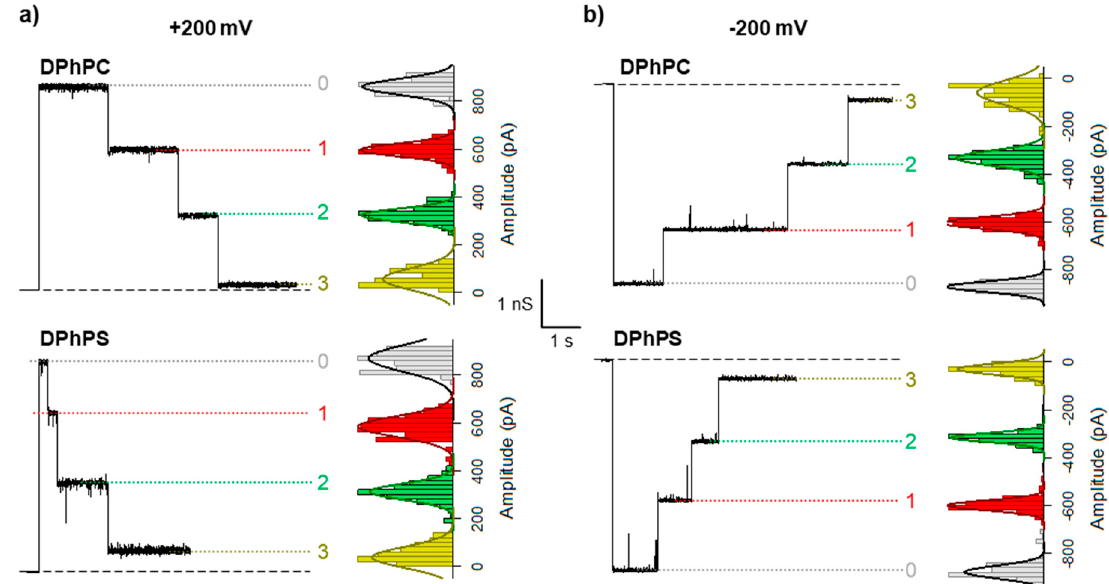
Figure 2. OmpF sequential closing depends on lipid headgroup charge. Representative current traces of a single OmpF trimer inserted in a neutral diphytanoyl-phosphatidylcholine (DPhPC, upper panels) or a negatively charged diphytanoyl-phosphatidylserine (DPhPS, lower panels) membrane, with the typical step-wise transitions after a high positive ( a ) or negative ( b ) voltage is applied. Next to each trace, the amplitude distributions are shown for each state (bar graph) with a Gaussian fitting (solid